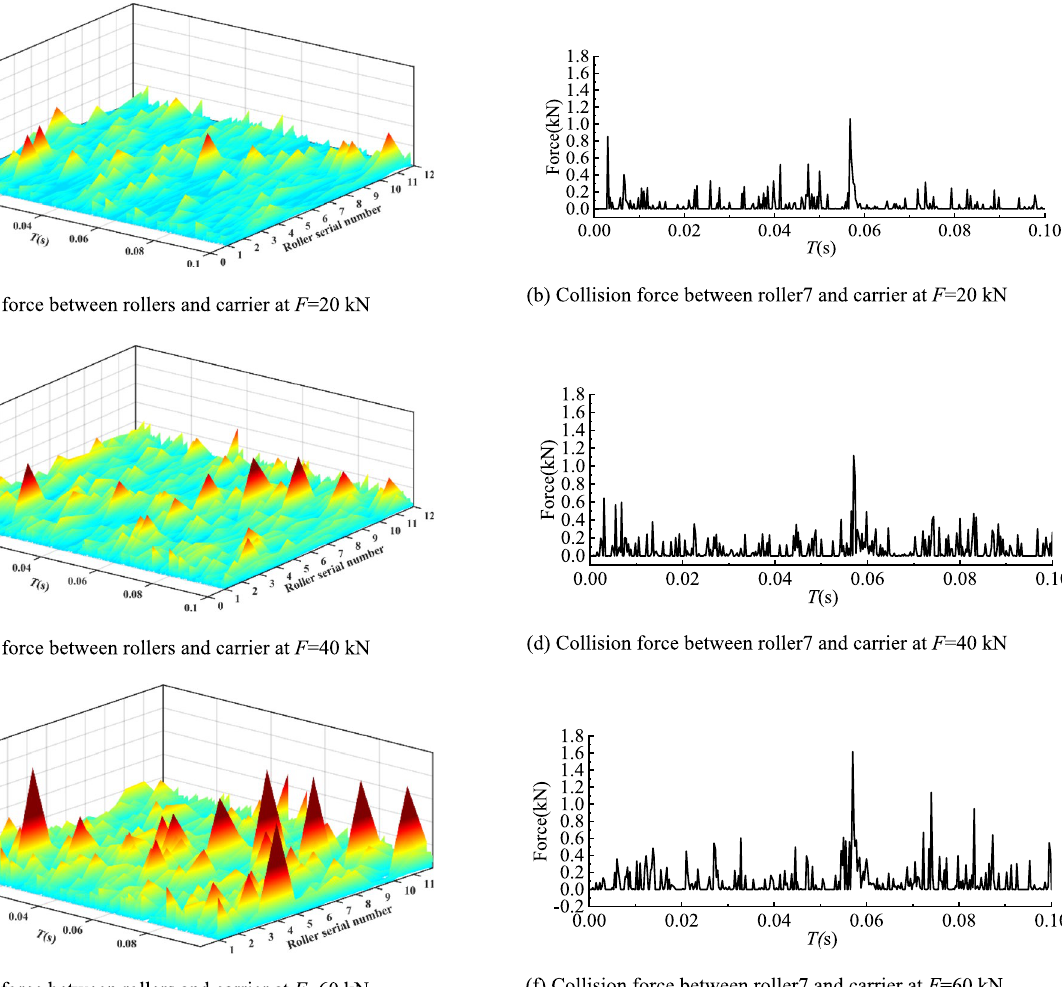
Figure 32 Collision force variation between rollers and carrier under three